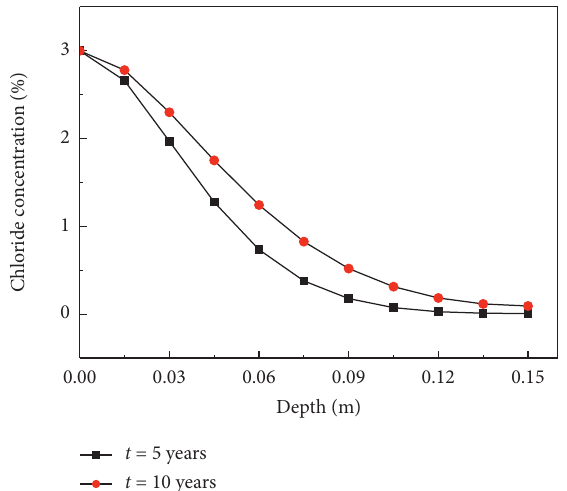
Figure 6: The chloride concentration at the diagonal of the concrete